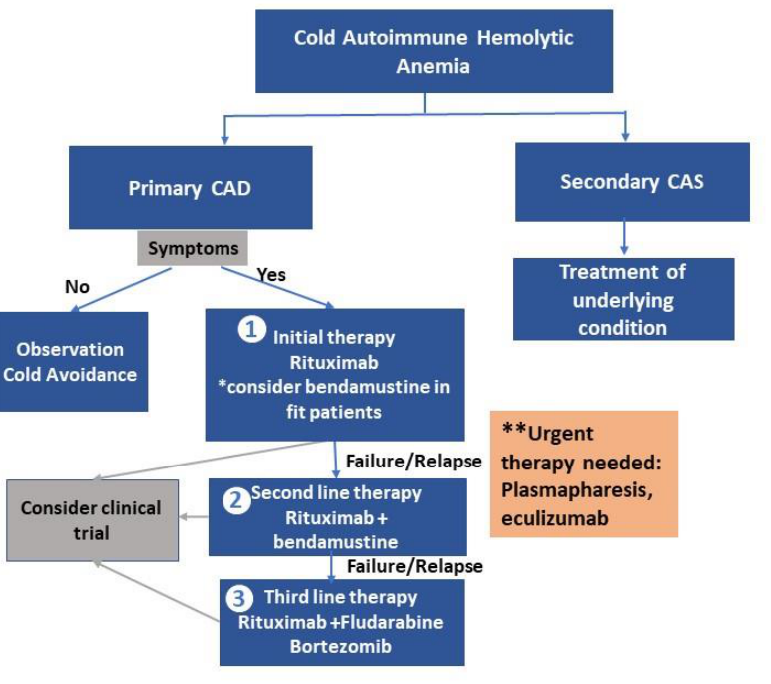
Figure 2. Treatment algorithm for cold agglutinin disease. CAD = cold agglutinin disease; CAS = cold agglutinin syndrome; “*” = consider bendamustine in fit patients; “**” = cases when urgent therapy is needed.